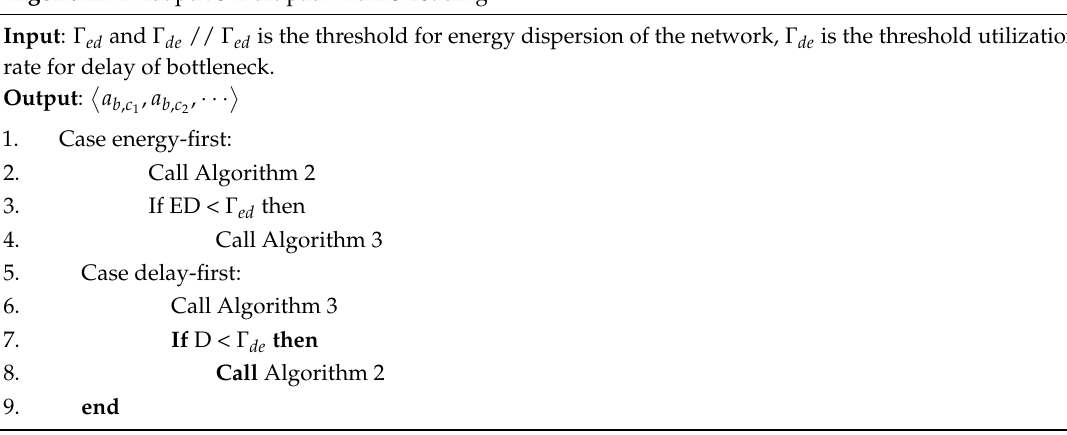
Algorithm 4 Adaptive Multipath Traffic